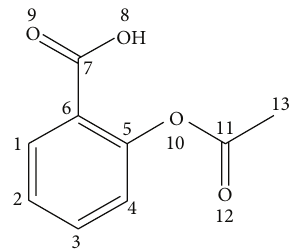
Figure 1: Aspirin molecule structure.